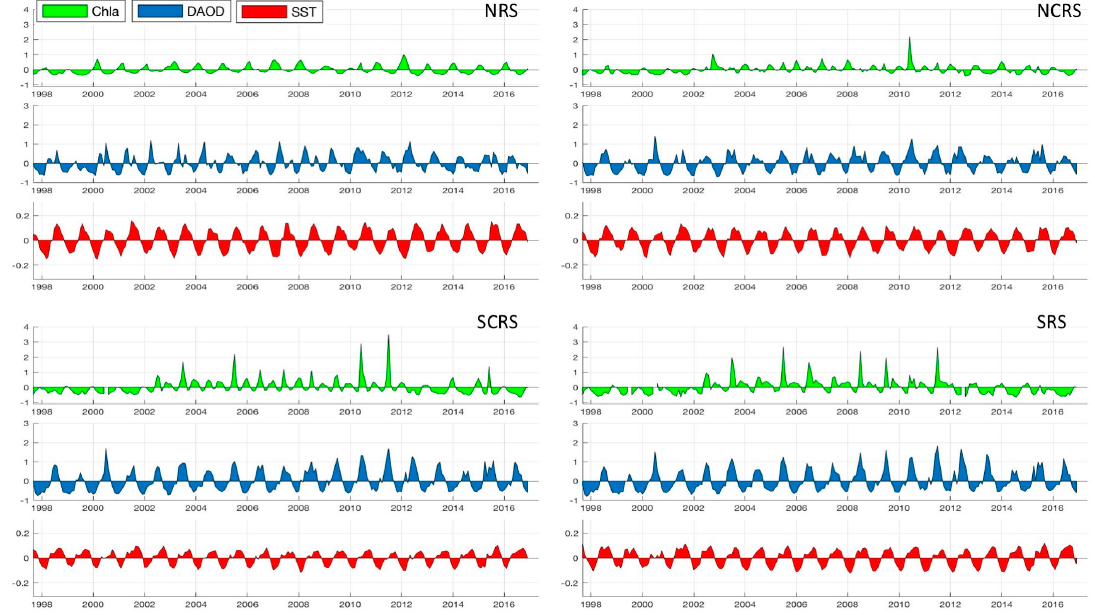
Figure 2. Time series of scaled values (see Equation (1)) for Chl- a , dust aerosol optical depth (DAOD) (MERRA-2 Dust Scattering AOT in 550 nm), and sea surface temperature (SST) for the four regions of the Red Sea represented in Figure 1.